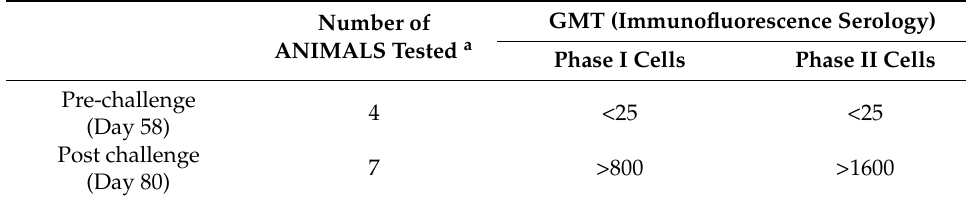
Table 4. Serological response to Vaccine A measured by micro-immunofluorescence.